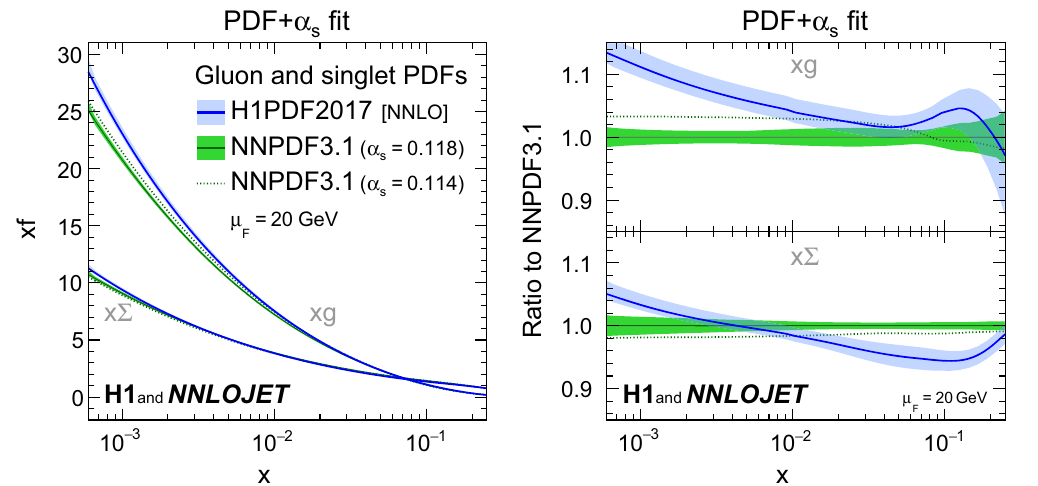
Fig. 16 Gluon and singlet distributions determined by the PDF+ α s -fit, denoted as H1PDF2017 [NNLO] , as a function of the convolution vari- able x (see Eq. (1)). The distributions are displayed at μ F = 20GeV.